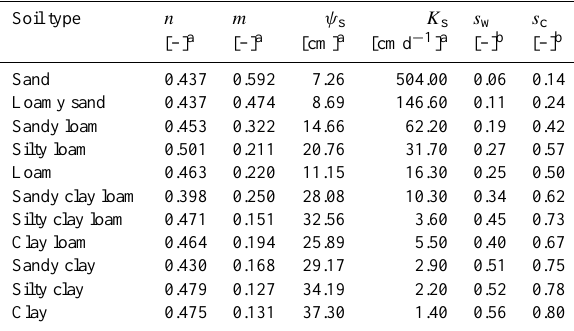
Table 1. Soil parameters associated with different soil textures ac- cording to the experiments by Rawls and Brakensiek (1989). a Pa- rameters taken from Rawls and Brakensiek (1989) and also reported in Rawls et al. (1993). b The relative saturation at the wilting point and the field capacity have been estimated using the Brooks–Corey model assuming ψ = − 1 . 5 and − 0.03Mpa,